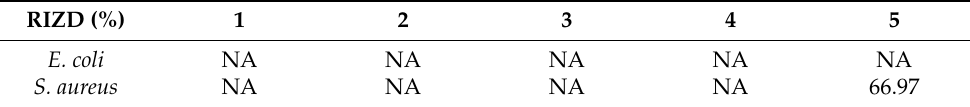
Table 10. Antibacterial activity of tested complexes. RIZD (%) means percentage of relative inhibition zone diameter. All complexes were tested against E. coli and S. aureus in three replicates (n = 3, ± SD). NA means no